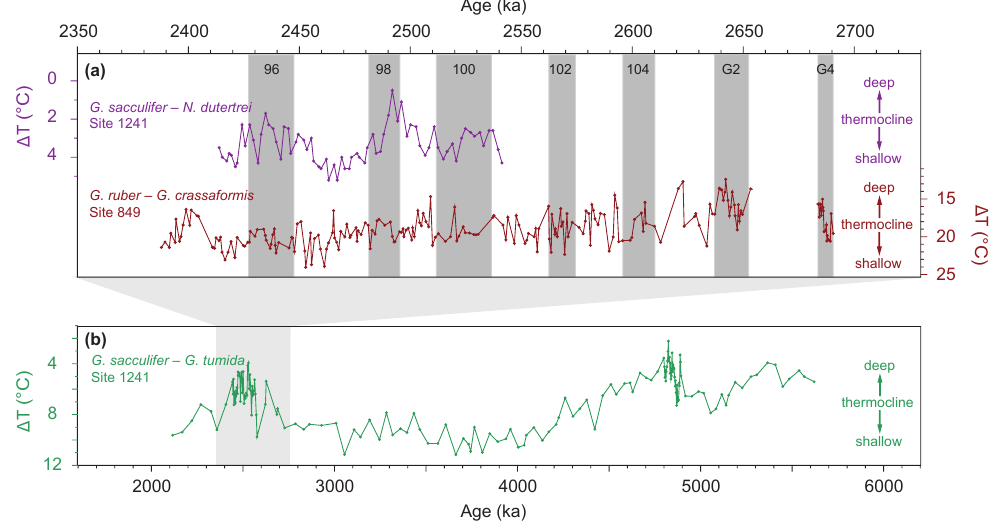
Figure 8. Comparison of selected thermocline-depth proxy records from the east Pacific for the ∼ 6–2Ma (bottom) and the ∼ 2 . 75–2.4Ma (top) intervals. (a) High-resolution surface to thermocline temperature gradients from Site 849 (red; this study) and Site 1241 (purple; Groeneveld et al., 2014) indicative of relative thermocline depth changes. (b) Low-resolution surface to thermocline temperature gradient from Site 1241 (green; Groeneveld et al., 2006; Steph et al., 2006a) reflecting relative thermocline depth changes. Light grey shading in (b) marks the investigated time period of this study. Grey bars in (a) highlight glacial